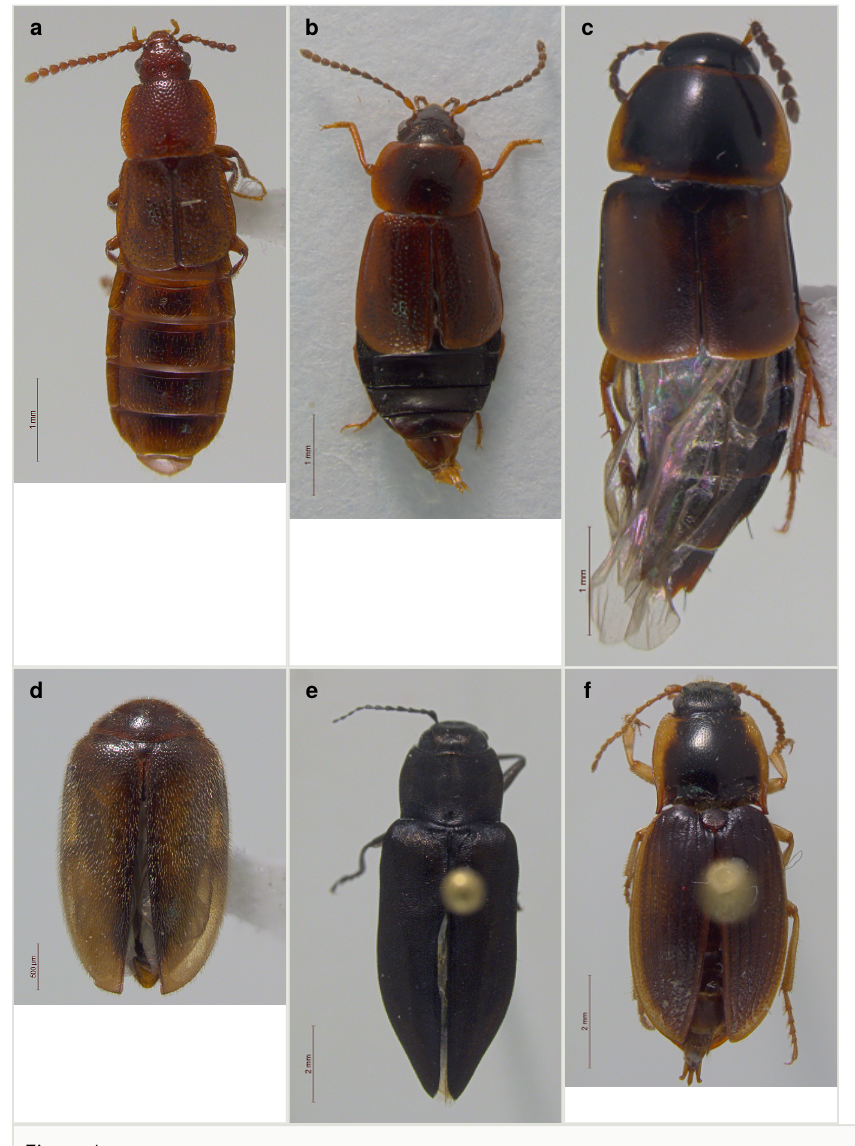
Figure 4. Photographs of some of the beetle species identi fi ed from Quingahak